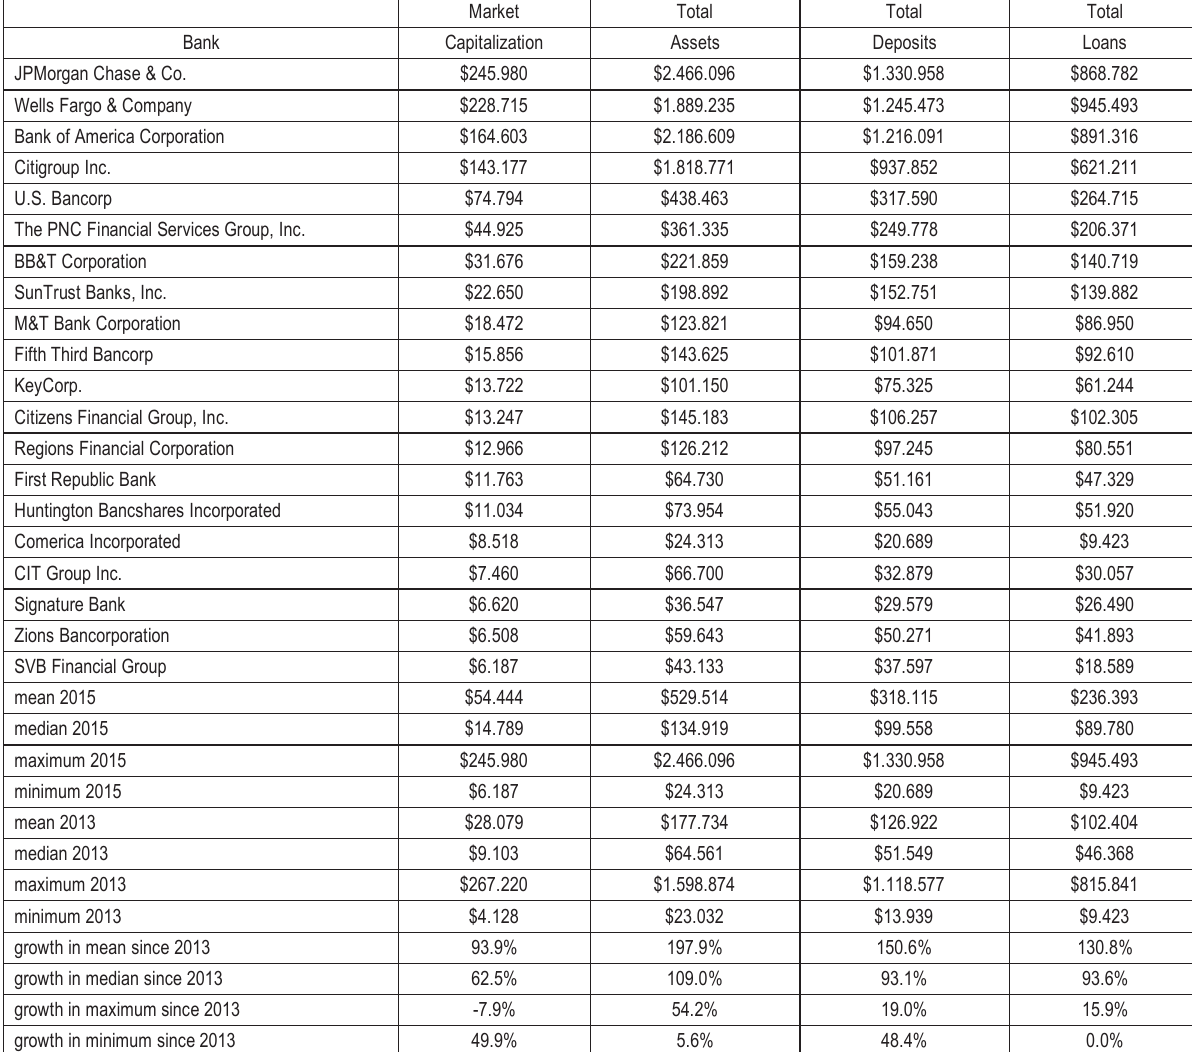
Table 1. Descriptive Statistics. Largest 20 U.S. Banks (in terms of market capitalization) designated